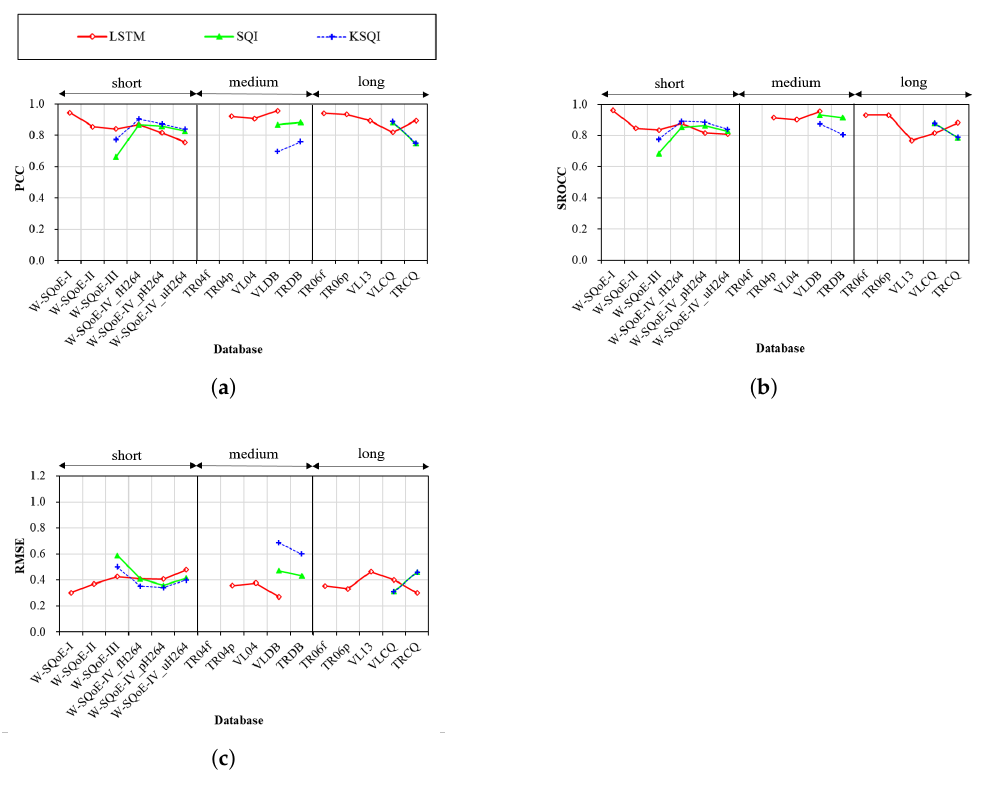
Figure 9. Performance of the LSTM , SQI , and KSQI models in the fourth group over the test databases. ( a ) PCC; ( b ) SROCC; ( c )